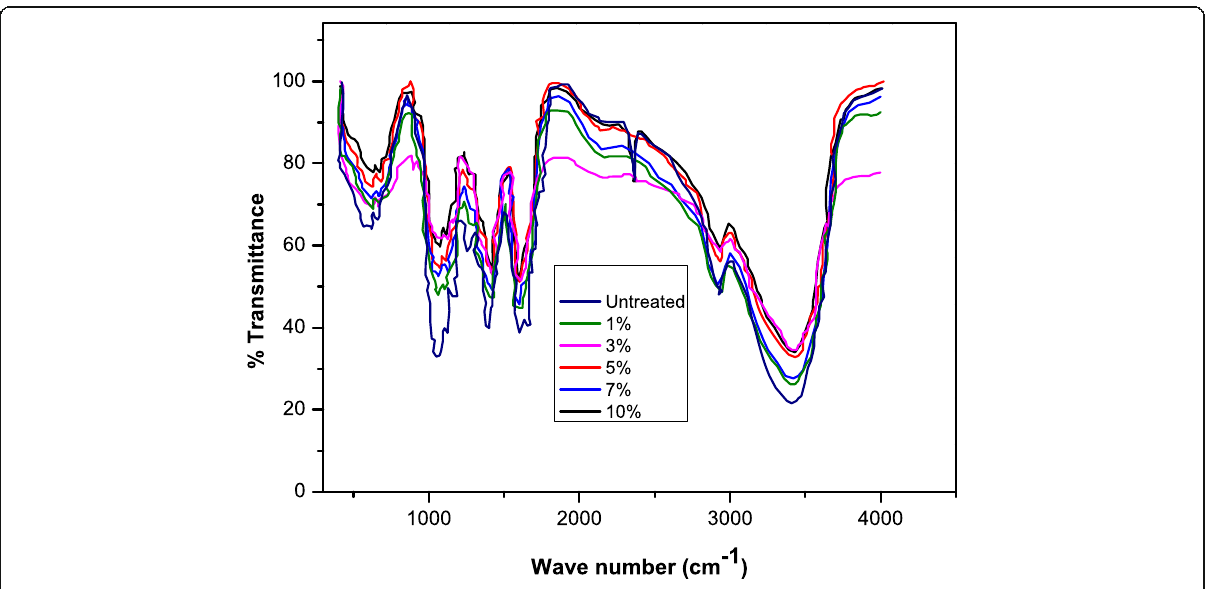
Fig. 4 FTIR spectra of native and NaOH pretreated rice